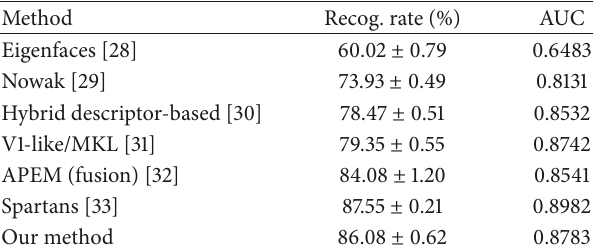
Table3:FaceverificationaccuracyofdifferentmethodsintheLFW- restricted